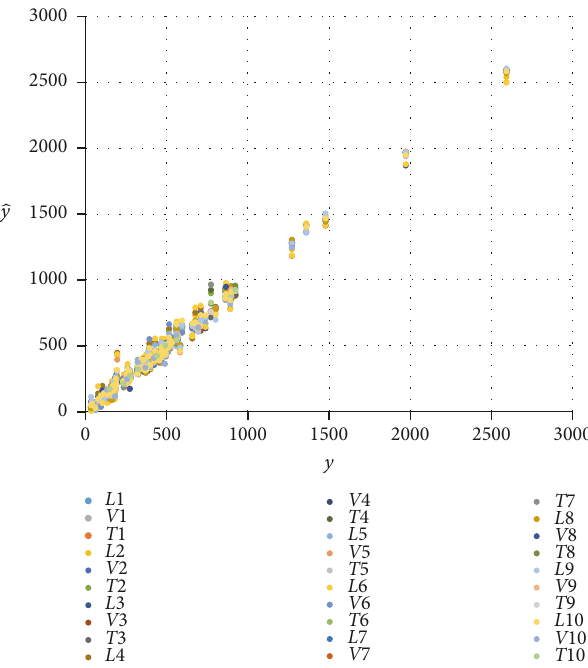
Figure 4: Scatter plot of ̂𝑦 and 𝑦 values for the selected MLP network (source: own